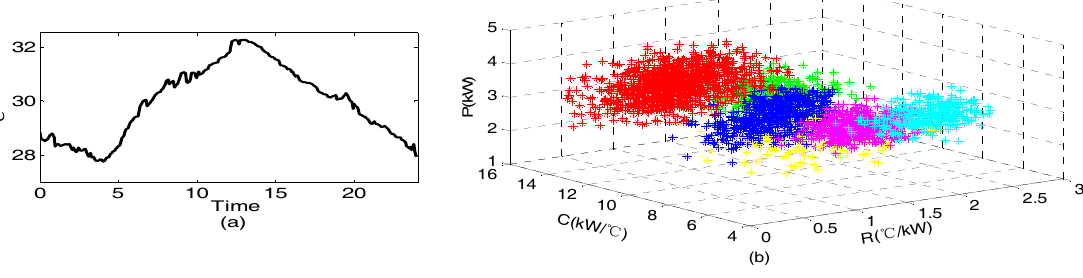
Figure 6. ( a ) The outdoor temperature curve of the day and ( b ) Six parameter clusters of 5000 ACLs. Table 1. Optimum comfort temperature set-points and related adjustments